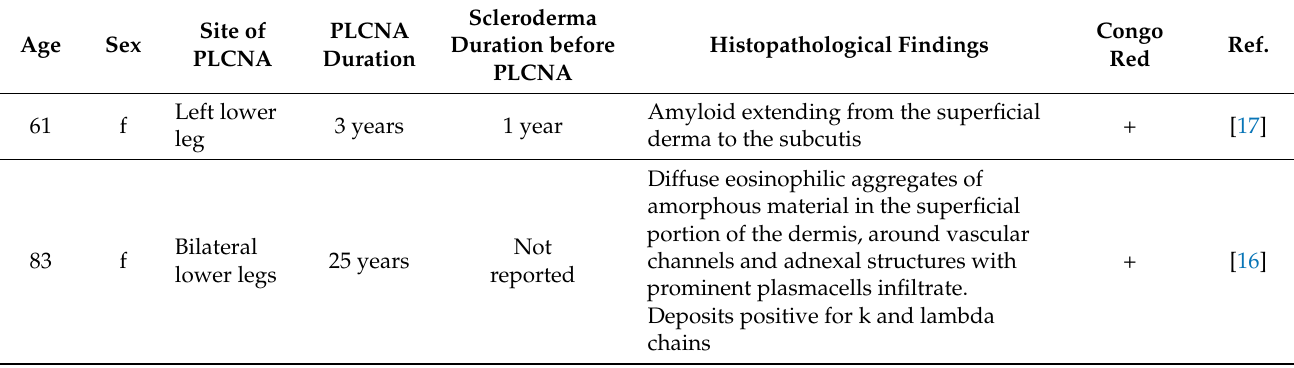
Table 1. PLCNA cases associated with scleroderma. (PLCNA primary cutaneous nodular amyloidosis; m, male; f,